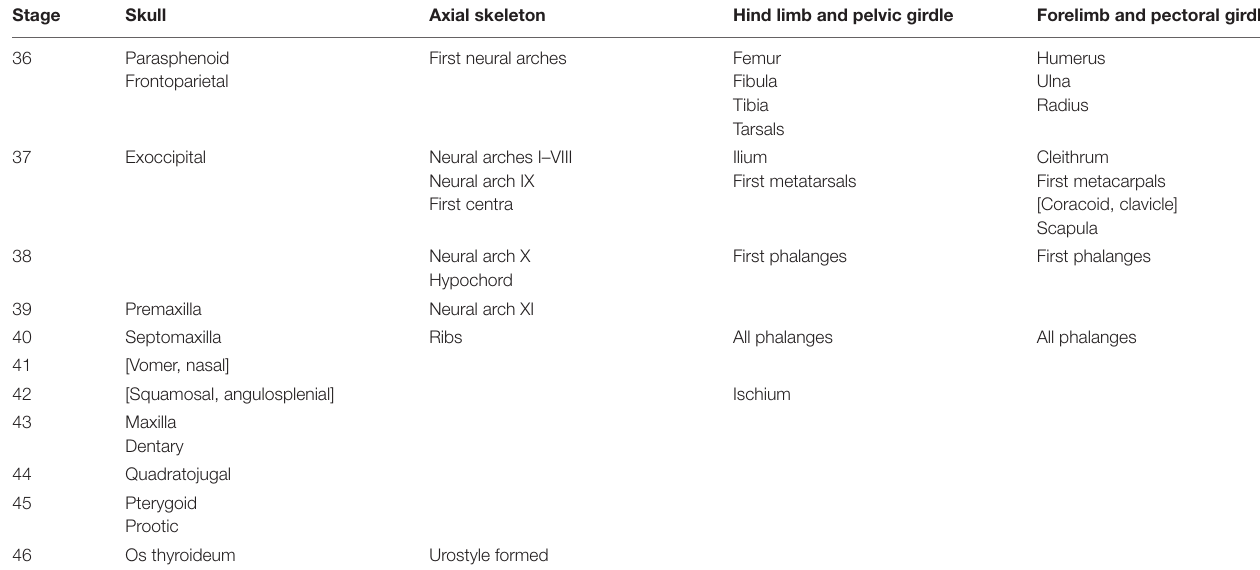
TABLE 2 | Sequence of skeletal ossification in Bombina variegata listed as the earliest bones appearance (normal development). Stage Skull